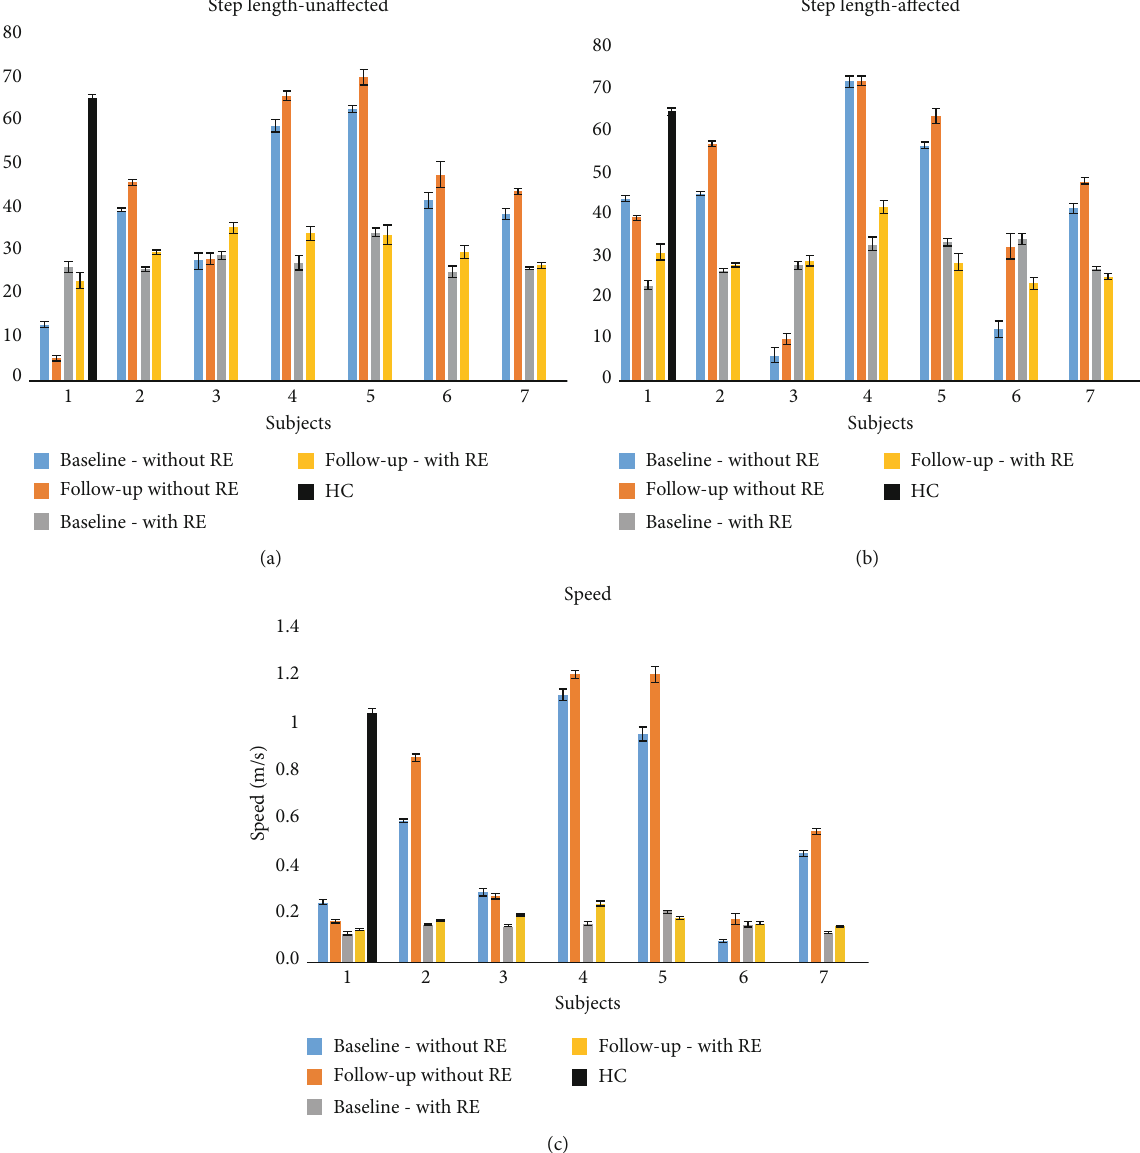
Figure 4: Mean ± standard error of the step length with and without the RE on the (a) a ff ected side, (b) una ff ected side, and (c) walking